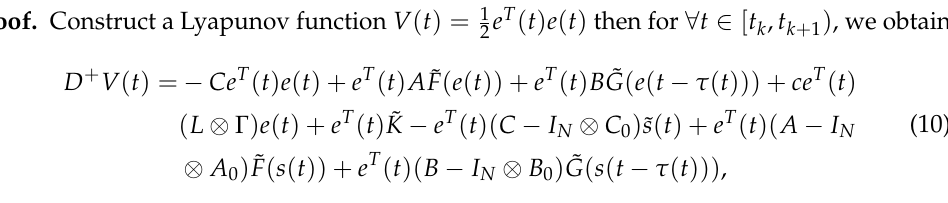
h ( t ) , φ k ( t ) , and V ( t ) , 2